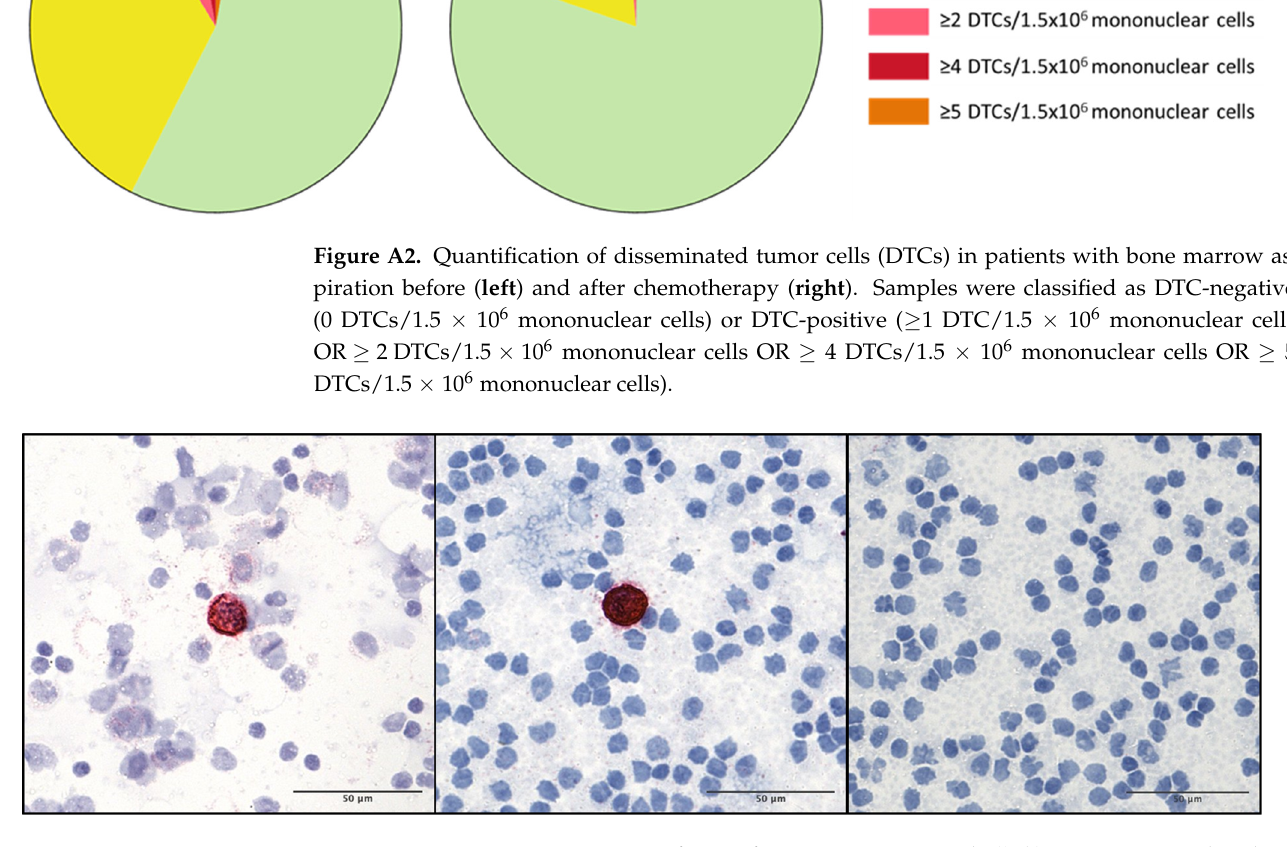
Figure A3. Representative images of: DTC from a patient’s sample ( left ), positive control with an SKBR-3 cell ( middle ), negative control ( right ); taken at 20× magnification.